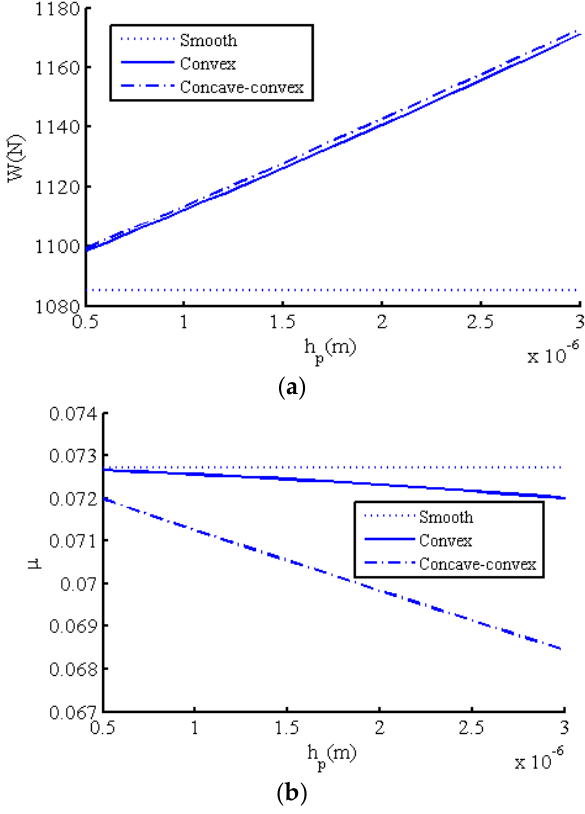
Figure 7. Effect of texture depth on ( a ) the load capacity and ( b ) the friction coefficient.